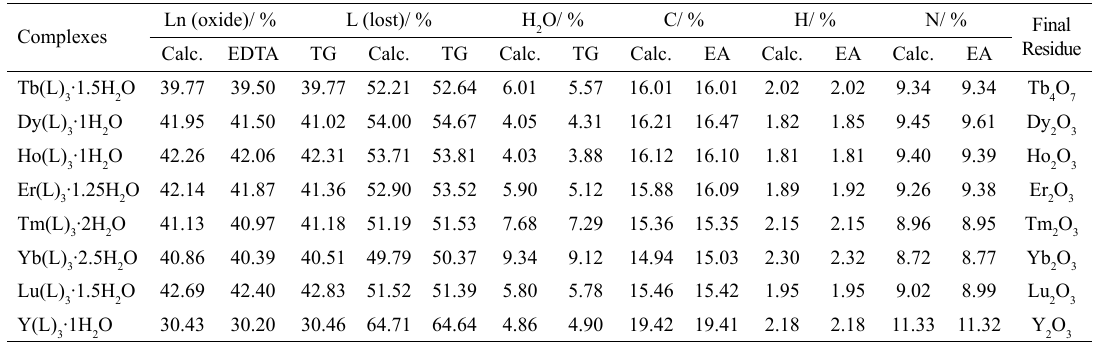
∙ n H O complexes. 3 2